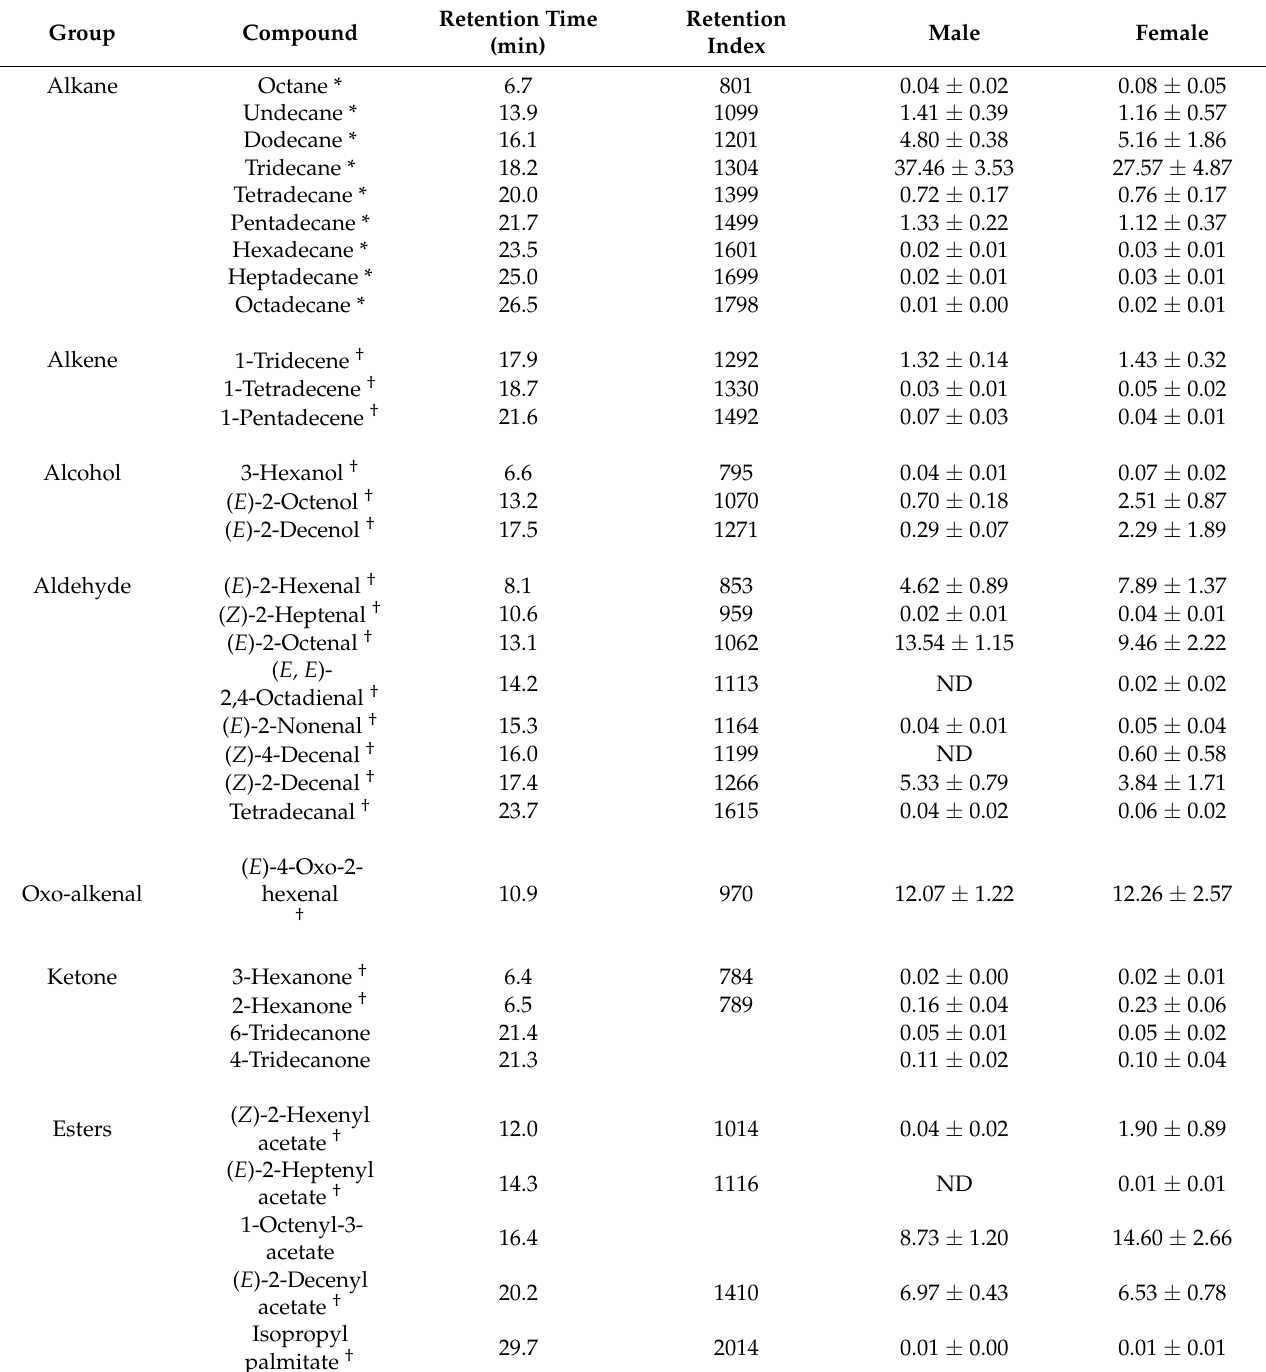
Table 3. Relative abundance (%) (mean ± SE) of different compounds found in the metathoracic gland extracts of adult rice stink bugs, Oebalus pugnax